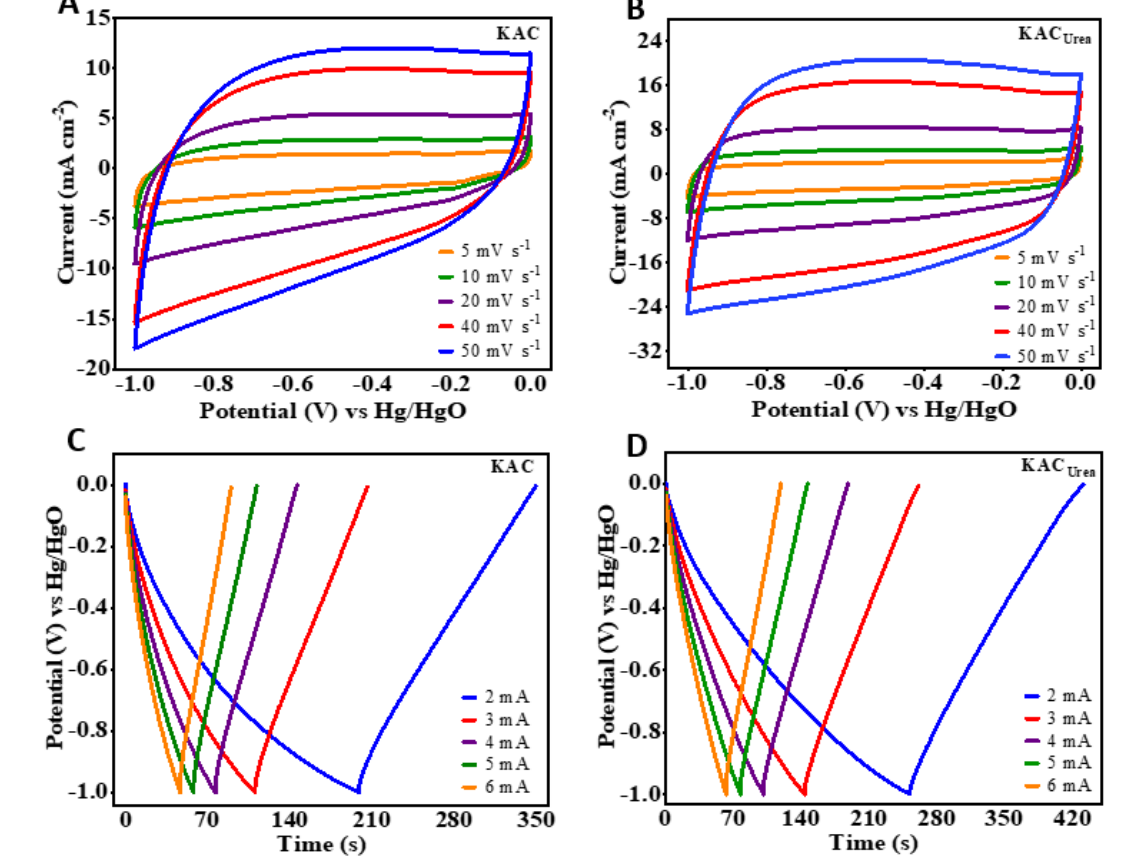
Figure 6. ( A , B ) Cyclic voltammetry (CV) and ( C , D ) galvanostatic charge – discharge (GCD) profiles of KAC and KAC urea . KAC and KAC urea